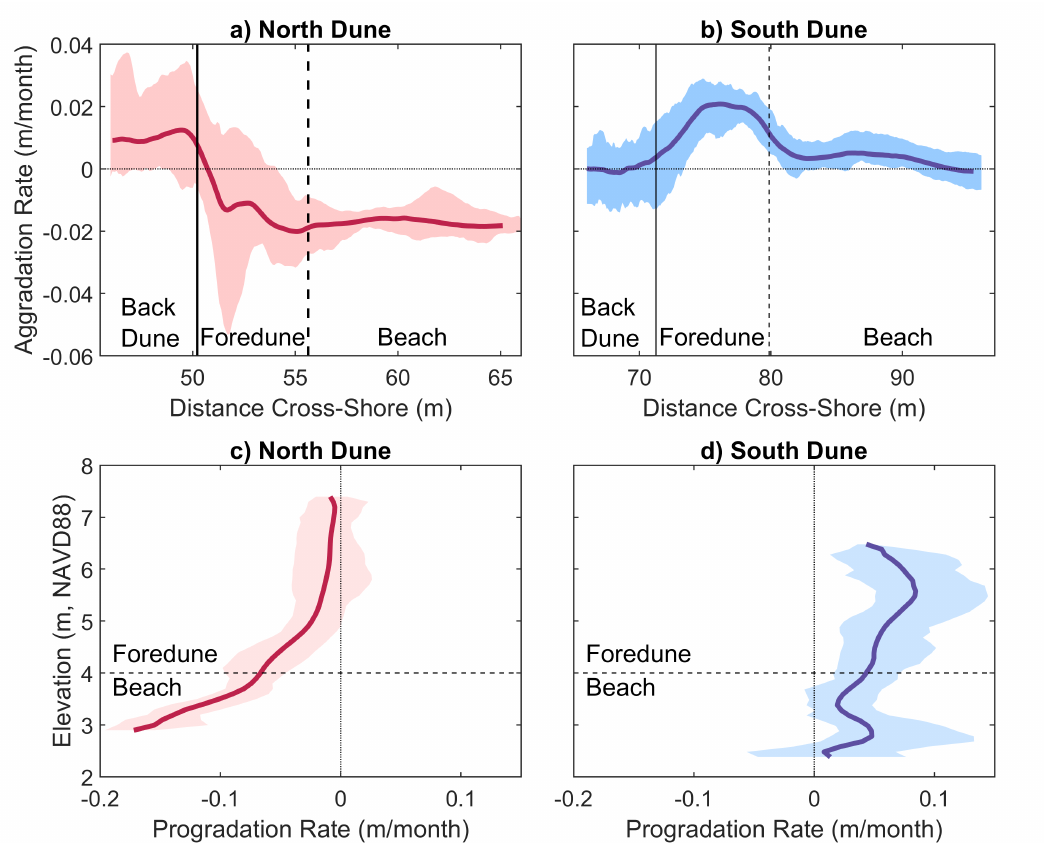
Figure 6. Dune morphology trend analyses. ( a , b ) Alongshore-averaged (solid line) vertical aggradation rates versus cross-shore position for the north and south dunes, respectively. The average cross-shore location of the dune crest, x c , and dune toe, x 4 m , are overlain in solid and dashed black lines, respectively, for each site. ( c , d ) Elevation versus alongshore-averaged horizontal progradation rate for the north and south dunes, respectively. For each site, the envelope of variability along the site are shown in the shaded